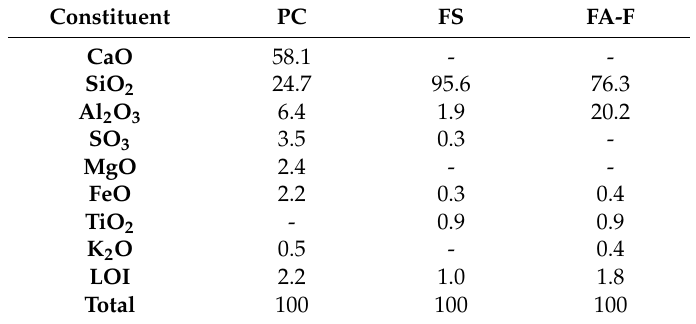
Table 3. Chemical composition by weight of Portland cement (PC), fine sand (FS) and fly ash (FA-F). Constituent PC FS FA-F CaO 58.1 - - SiO 2 24.7 95.6 76.3 Al 2 O 3 SO 3 0.3